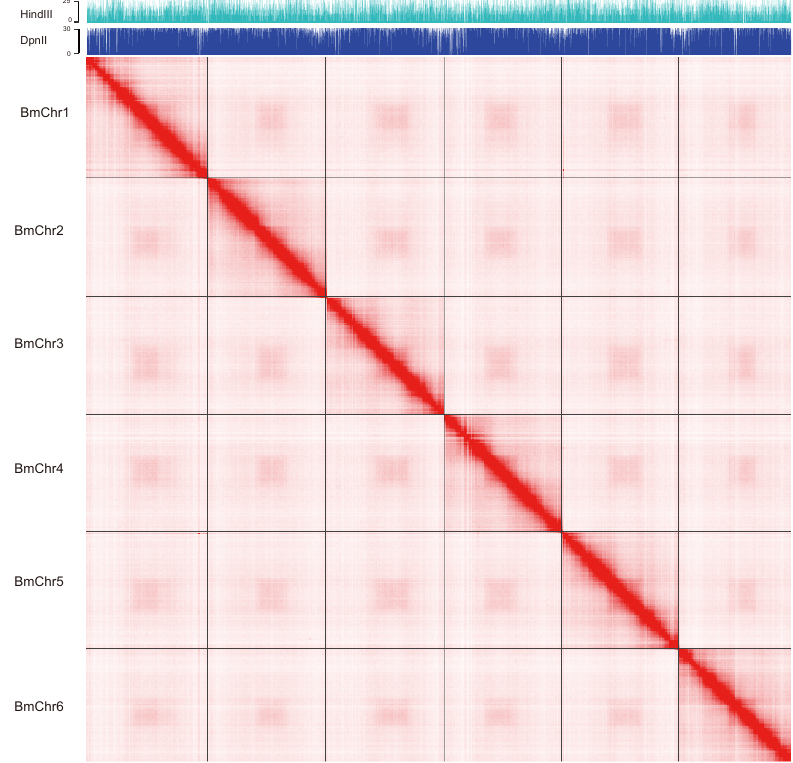
Figure 2. Hi-C contact heatmap of pseudo-molecules. The blocks represent signal associated with the two contact positions. All six blocks are evaluated by the genome coverage of Hi-C library of HindIII and DpnII.